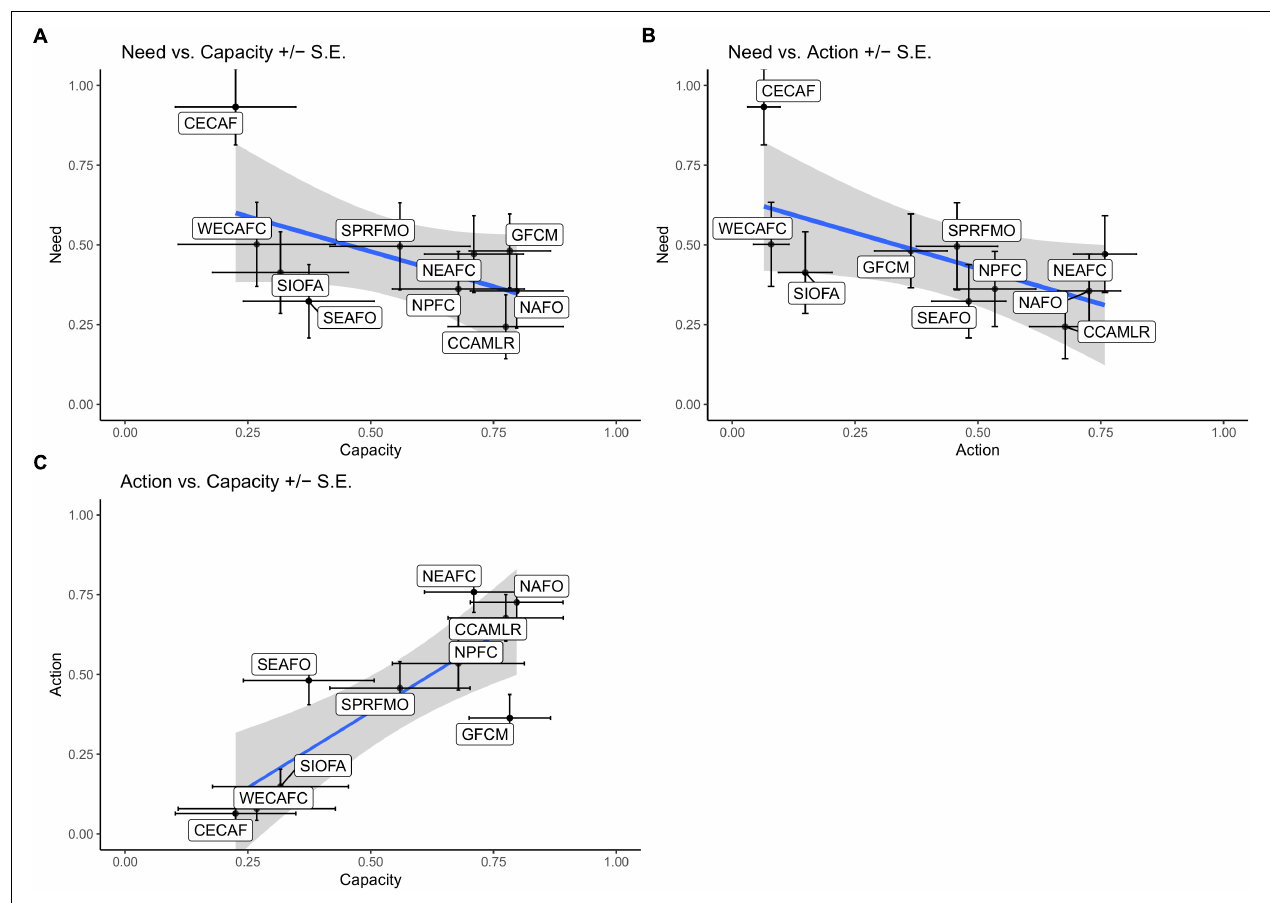
FIGURE 3 | Comparisons of the “capacity,” “need” and “action” scores. Gray area = S.E. of generalized linear model (blue line). See Supplementary Appendix S2 for 3-D CAN scores graphic. CCAMLR – Convention for the Conservation of Antarctic Marine Living Resources; CECAF – Fisheries Committee for the Eastern Central Atlantic; GFCM – General Fisheries Commission for the Mediterranean; NAFO – Northwest Atlantic Fisheries Organization; NEAFC – North-east Atlantic Fisheries Commission; NPFC – North Pacific Fisheries Commission; SEAFO – South-east Atlantic Fisheries Organisation; SIOFA – South Indian Ocean Fisheries Agreement; SPRFMO – South Pacific Regional Fisheries Management Organisation; WECAFC – Western Central Atlantic Fishery